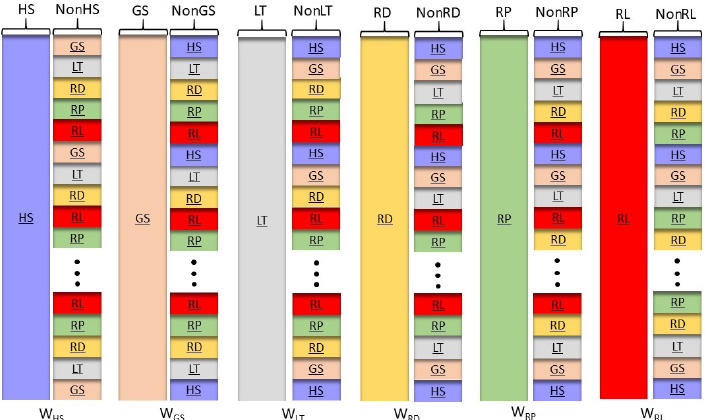
Figure 5. One-versus-rest arrangement of EEG data for calculation of CSP spatial filters of six motor events, W HS , W GS , W LT , W HD , W RP and W RL